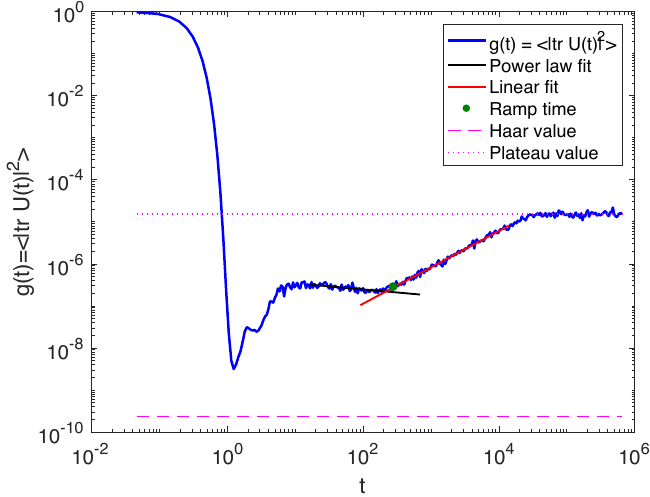
Figure 11 . The spectral form factor for the local randomly coupled qubits (Local-RCQ) for N = 16 qubits is given by the blue curve. We (cid:12)t two di(cid:11)erent lines in the log-log plot to the bump and the ramp (two red lines) and determine, the (cid:12)rst, time scale where two red lines intersect and, the second, where fractional error of the blue curve from the best (cid:12)t of the ramp is (cid:15) . In the plot the green dot represents the ramp time estimate with the second method, when fractional error is 5 %.